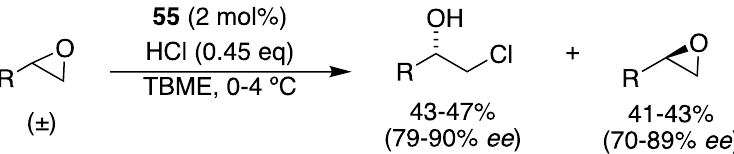
Figure 53. Cr–salen complex 133